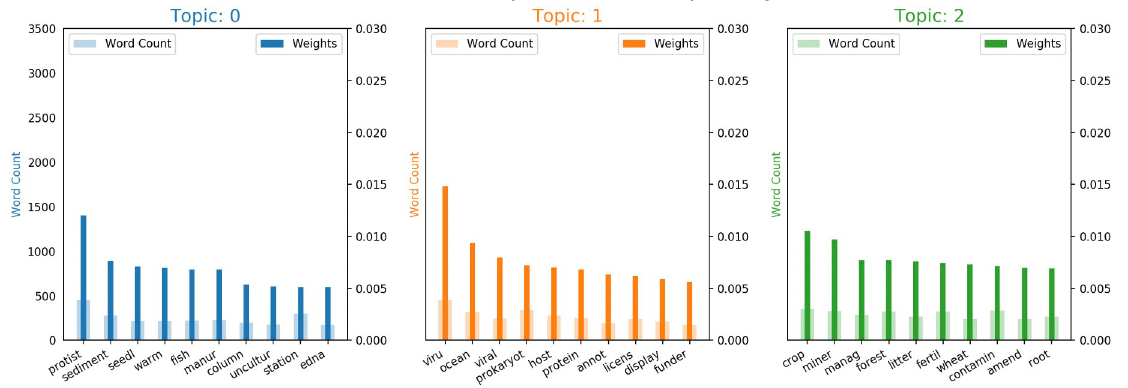
Fig 7. shows the word count and word weight for the top lemmatized (truncated) words in each topic based on their attributes and by manipulating the outputs of the matplotlib library. The most common words in each topic can give insights to what the potential topics